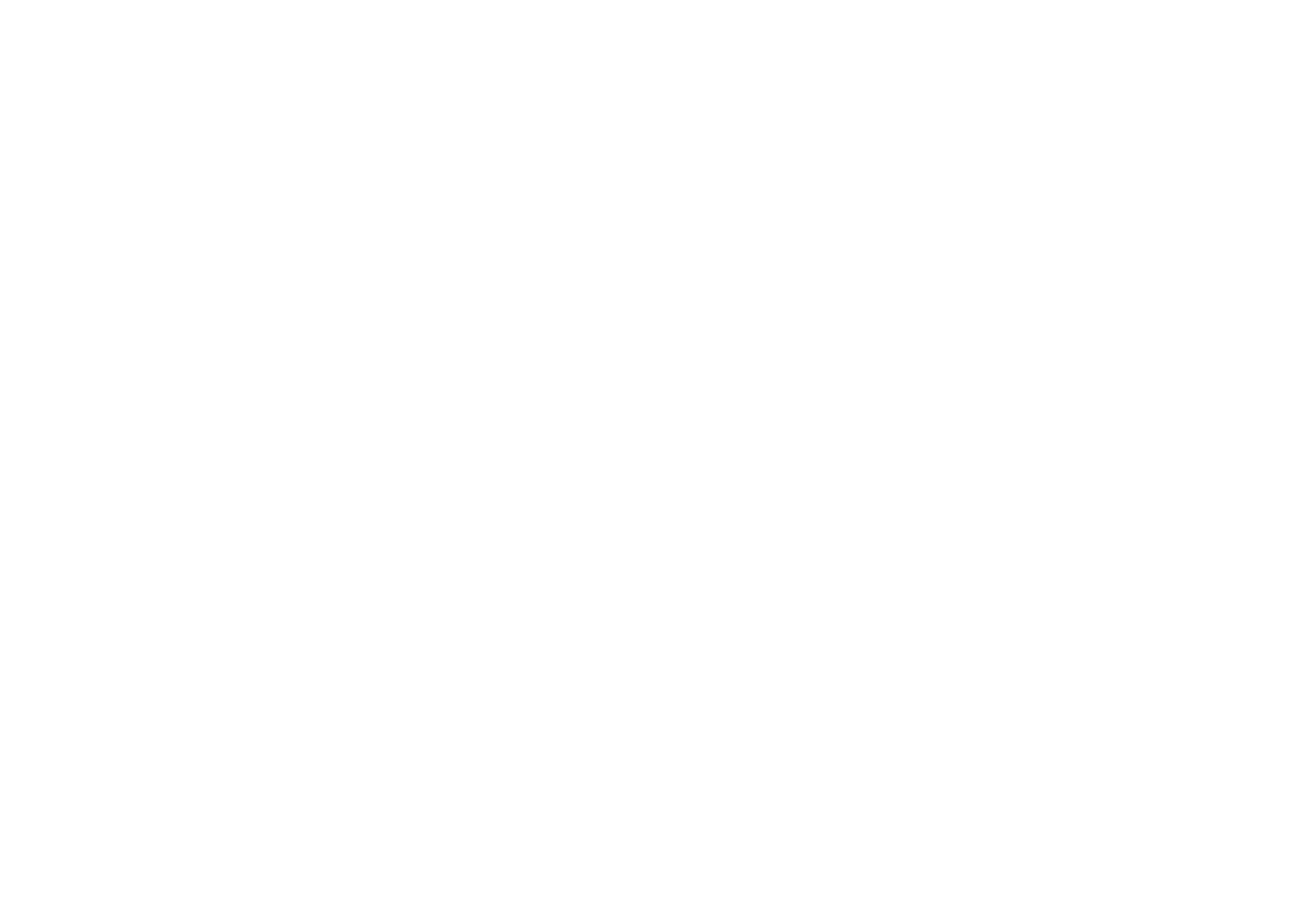
FIGUREA1 |Total number of genes differentially expressed by molsidomine at each age per gender. Hundreds of genes were significantly affected by molsidomine at each age in both genders.The distribution of the genes over all ages is shown in aVenn diagram.The up